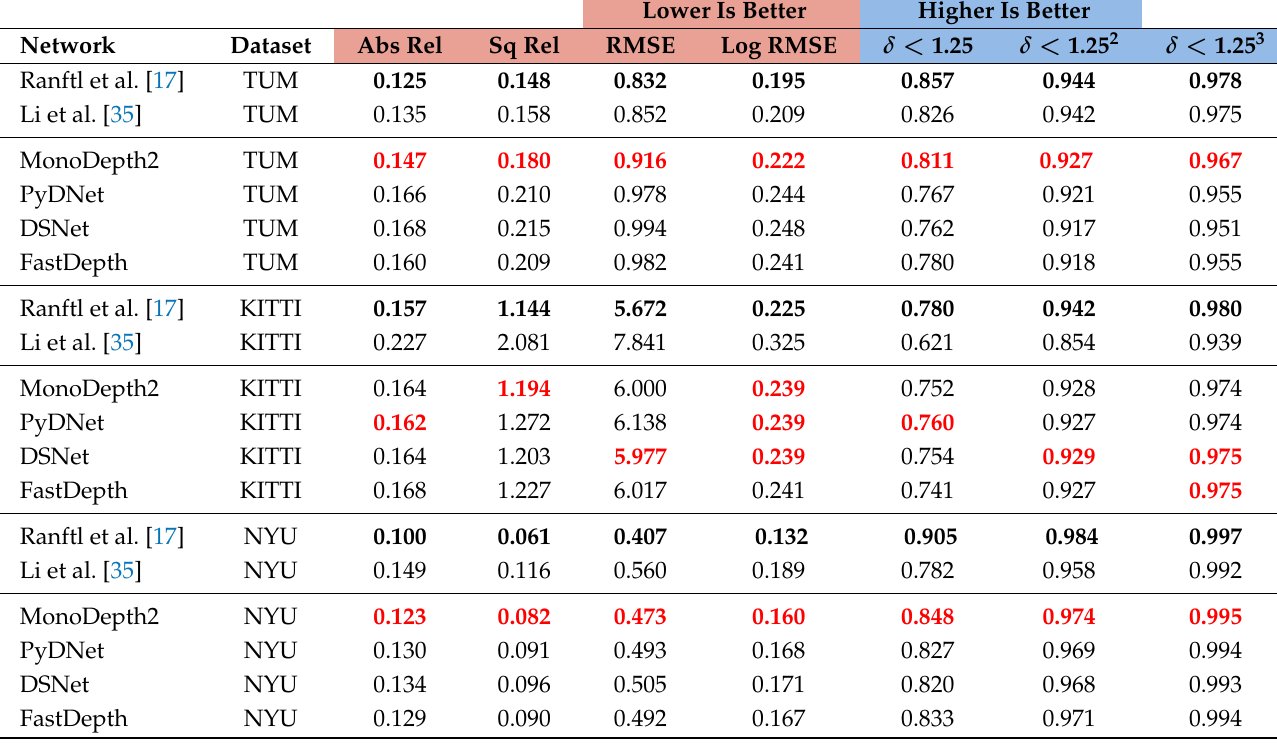
Table 2. Evaluation of generalization capability. The three groups from top to bottom report experimental results concerning, respectively, (top) TUM dataset, (middle) KITTI Eigen and (bottom) NYUv2. Lower Is